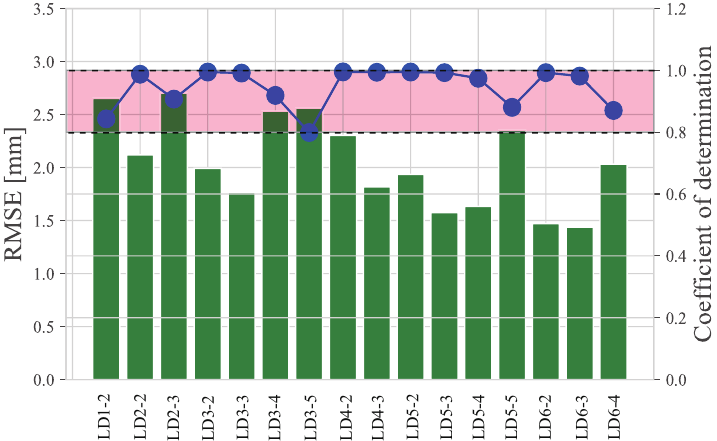
Figure 12. Coefficient of determination and RMSE of the proposed model.